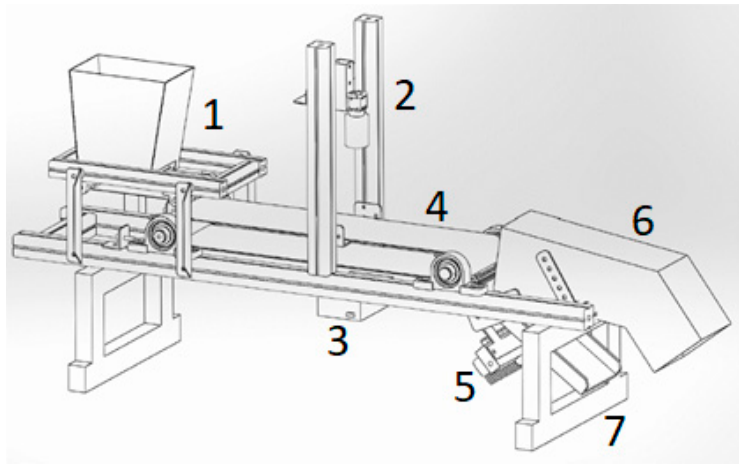
Figure 1. Sorting machine prototype with marked components: 1. Feeder, 2. Camera, 3. Illumination,